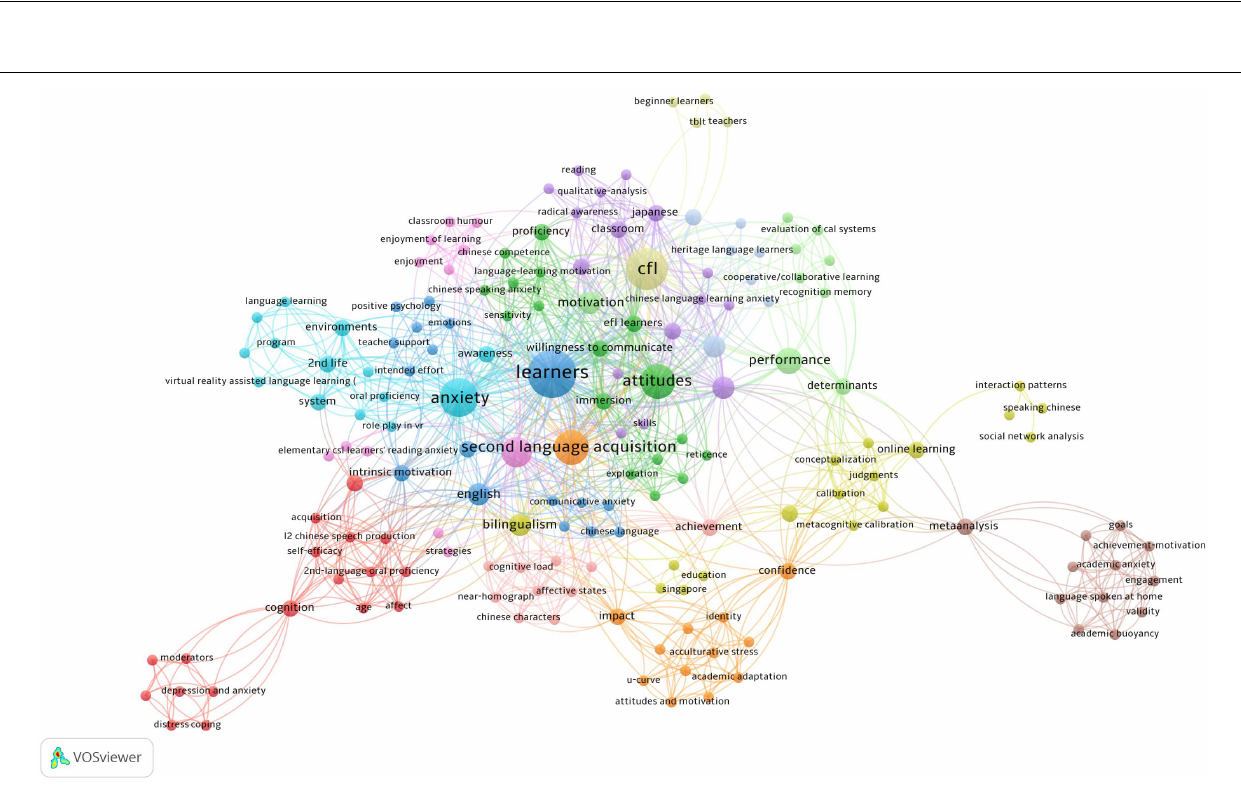
FIGURE 4 | English translation of keywords co-occurrence in Chinese language articles.